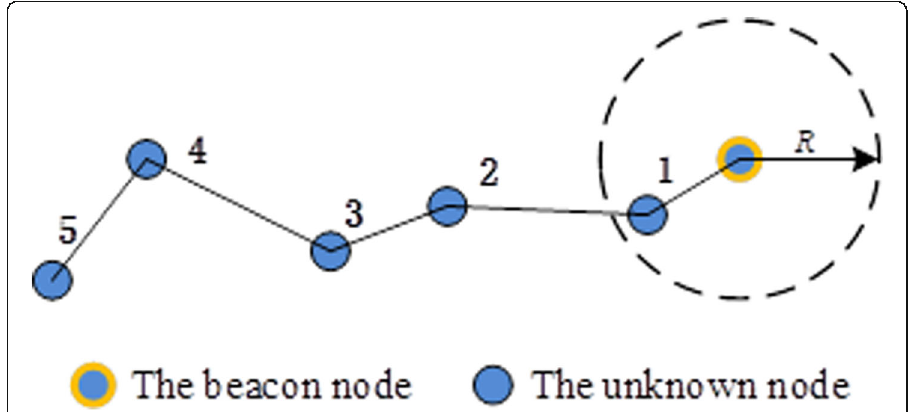
Fig. 1 Calculation of the number of hops between the